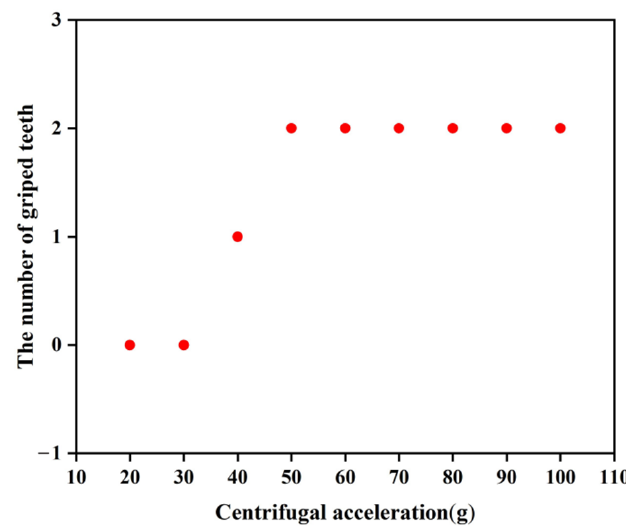
Figure 28. Locking state. Figure 28. Locking